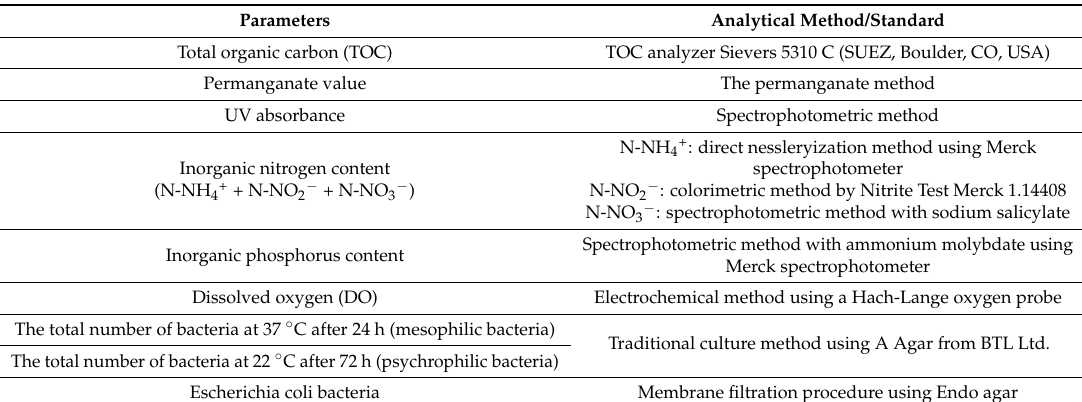
Table 3. Summary of analytical methods for laboratory experiments